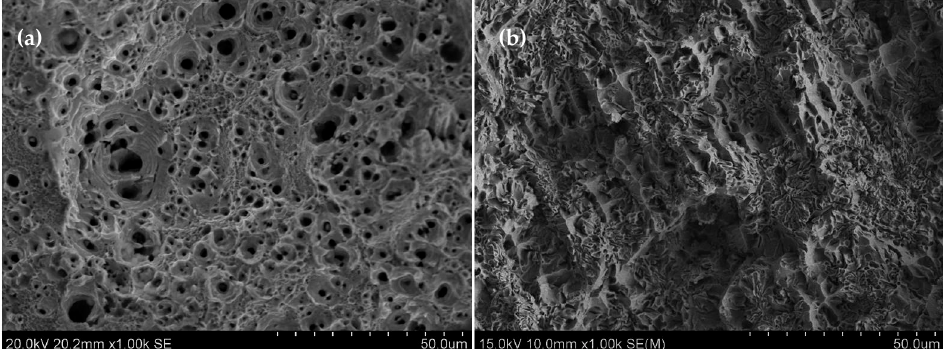
Figure 7. SEM image of tensile fracture:( a ) as received SS304; and ( b ) pressure quenching SS304.